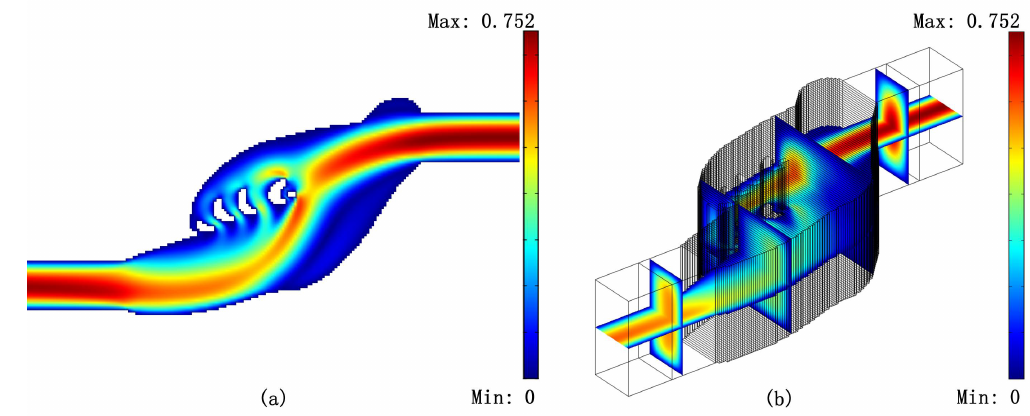
Figure 7. Reverse flow velocity field of the 2D model ( a ) and its 3D counterpart ( b ) for the optimized Tesla valve with the value of C max = 0.600 in Figure 4.